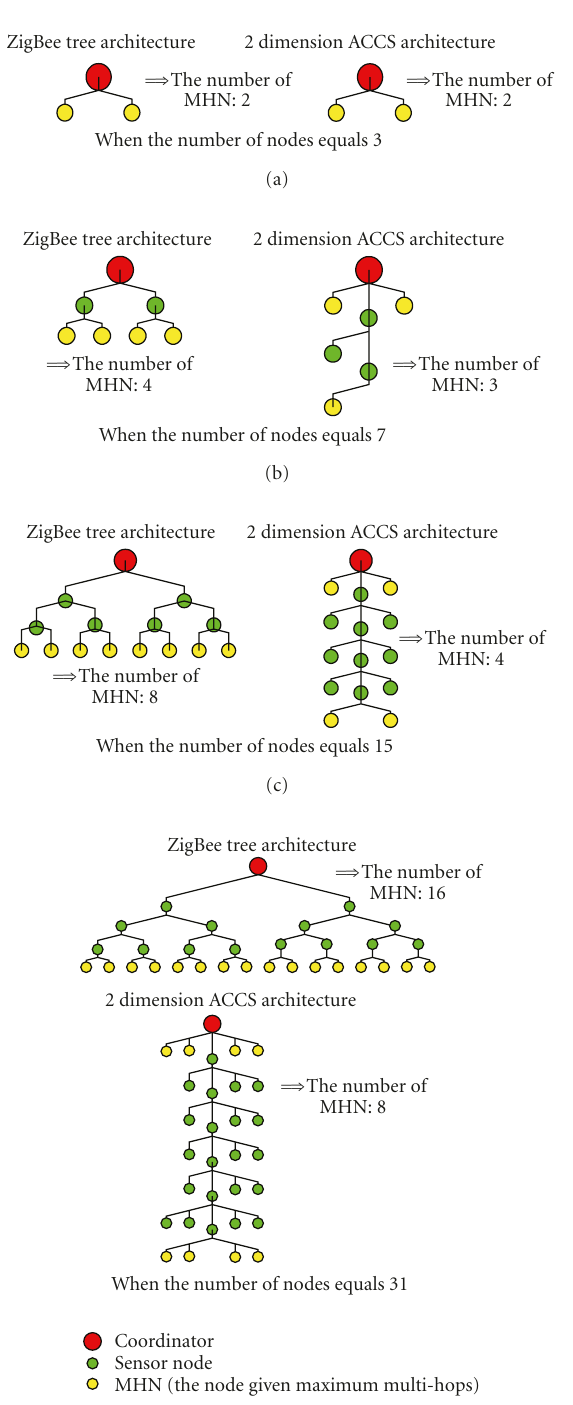
Figure 12: Several network topologies assigned by individual address assignment algorithms.